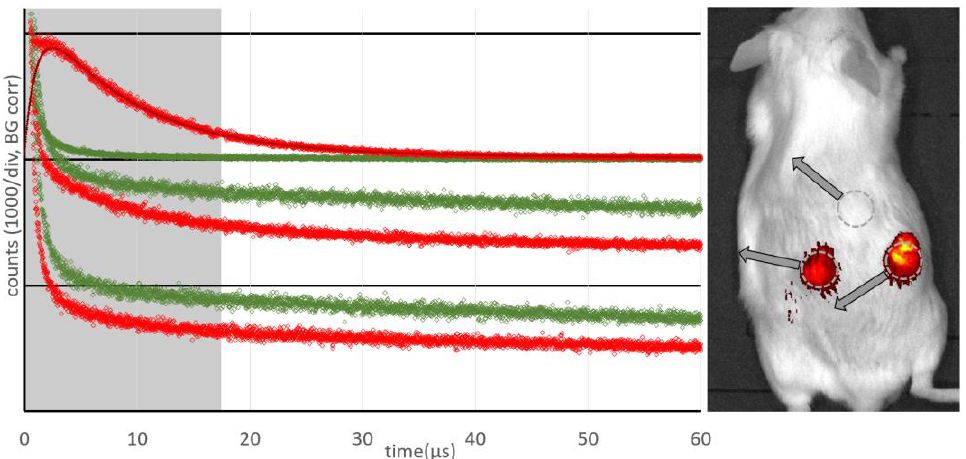
Figure 2. Phosphorescence kinetics in vivo recorded for healthy tissue including a typical fit ( top ), at a tumor ( middle ) and at a necrotic tumor ( bottom ) for wavelengths around 1200 nm (green) and 1270 nm (red). Detection spots are indicated in the fluorescence image overlay of the mouse with a cutoff at 30% of maximum intensity